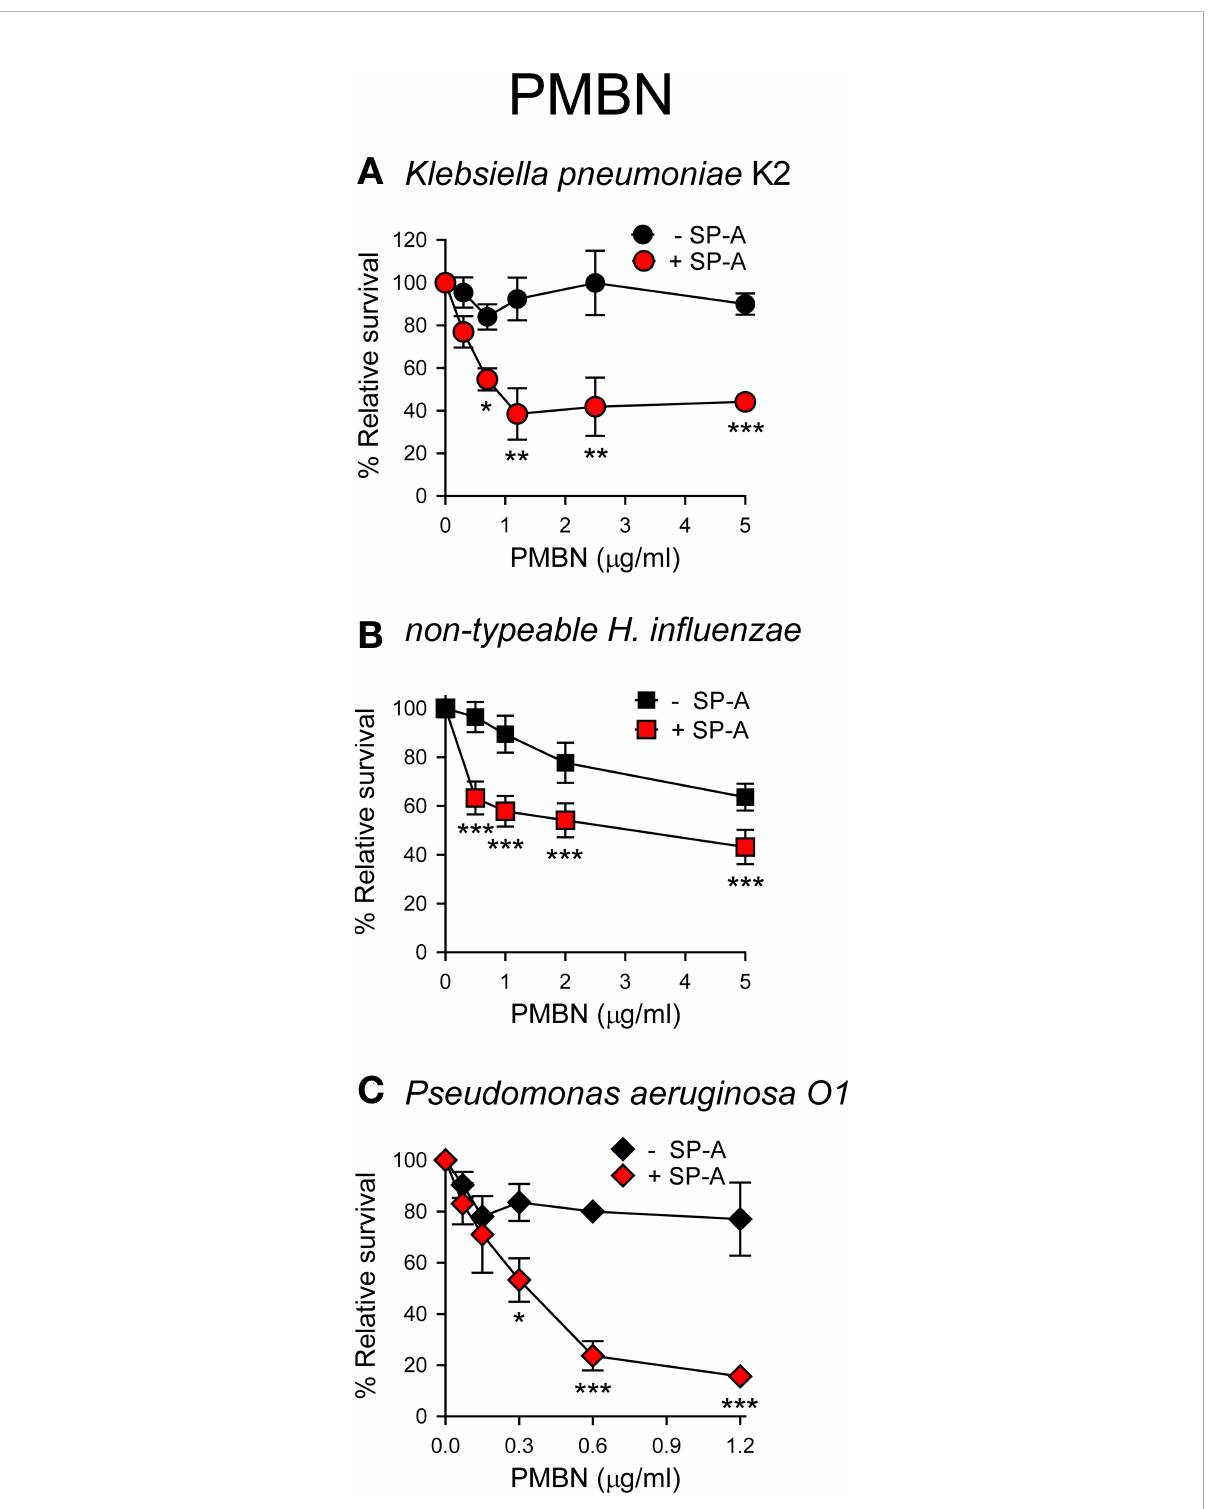
FIGURE 8 SP-A/PMBN complexes kill Gram-negative bacteria. 10 5 CFUs/ml of K pneumoniae (A) , NTHi (B) , and P. aeruginosa O1 (C) were incubated with increasing concentrations of PMBN in the absence or presence of SP-A (100 m g/ml for Kp and PAO1; 25 m g/ml for NTHi) for 1 h at 37°C. Bacteria were then plated on LB agar ( Kp and PAO1) or sBHI agar (NTHi) for CFU counting. Results are shown as a percentage of relative survival compared to untreated bacteria. Data are means ± SD of four independent experiments, with three biological replicates. Results were statistically analyzed by one-way ANOVA followed by the Bonferroni multiple-comparison test. * p < 0.05, ** p < 0.01, and *** p < 0.001 when bacteria treated with SP-A+PMBN were compared against bacteria treated with